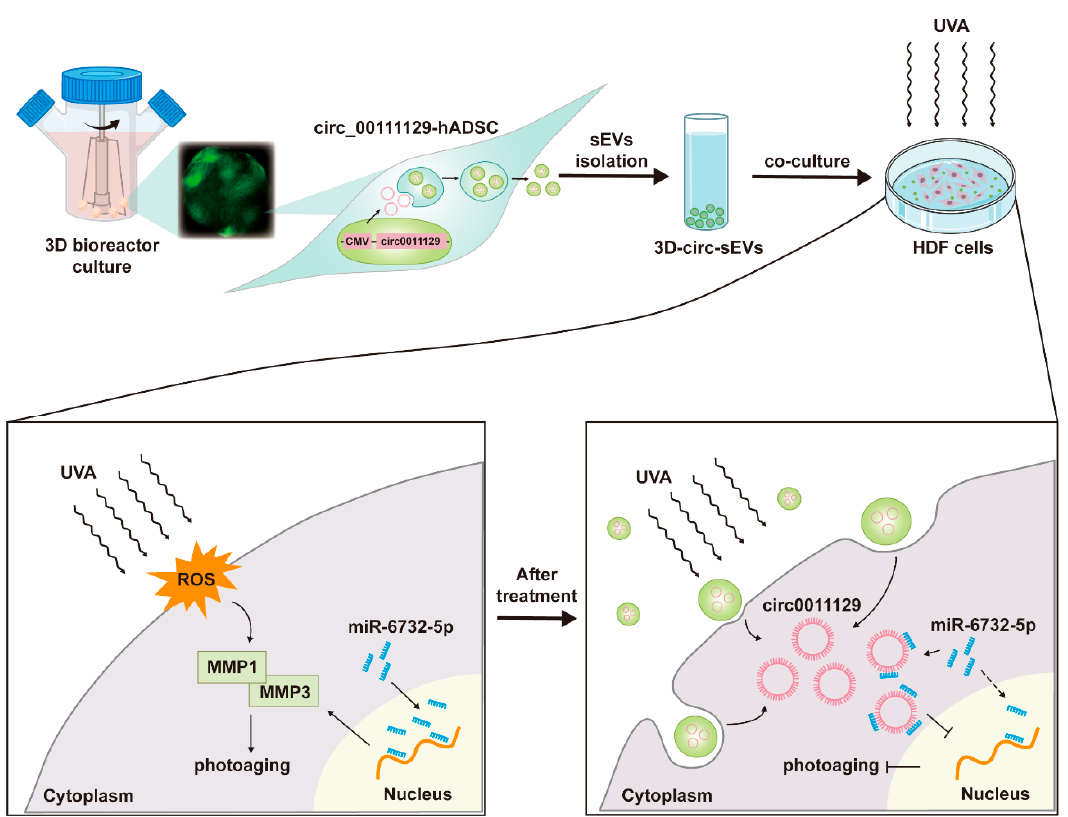
Figure 6. Schematic illustration of the mechanism of interference with the process of cell photoaging. 3D-circ-sEVs were purified from condition medium of circ_0011129-hADSCs in 3D bioreactor culture. Then, HDF cells were co-culture with 3D-circ-sEVs before or during successive UVA irradiation. Ultimately, circ_0011129 were accumulated in cytoplasm, adsorbing miR-6732-5p to inhibit its binding to target RNA. These effects contribute to interfere with the process of cell photoaging.